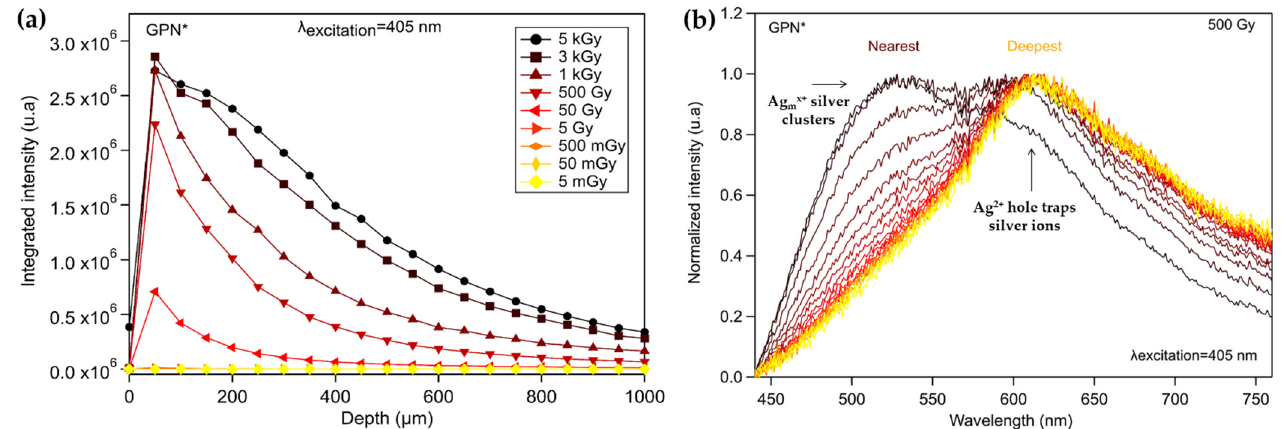
Figure 4. Micro-luminescence of GPN* glass performed on the optically polished glass side: ( a ) integrated fluorescence intensity at different depths, ( b ) normalized spectrum evolution with depth for the 500 Gy dose [39].